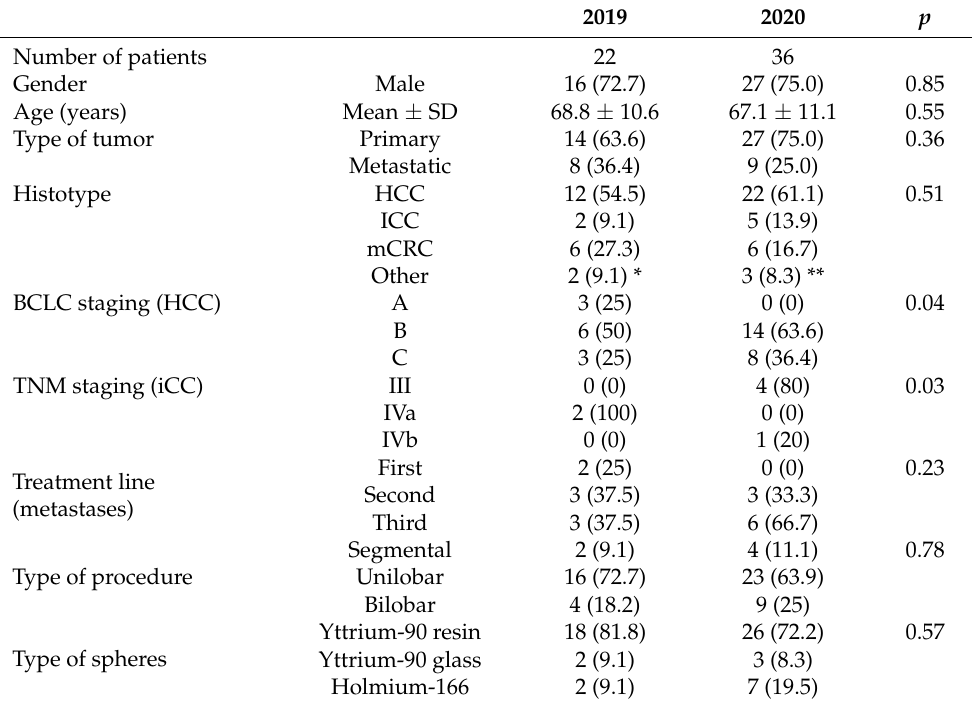
Table 1. Data of treated patients who underwent SIRT in March–July period: comparison